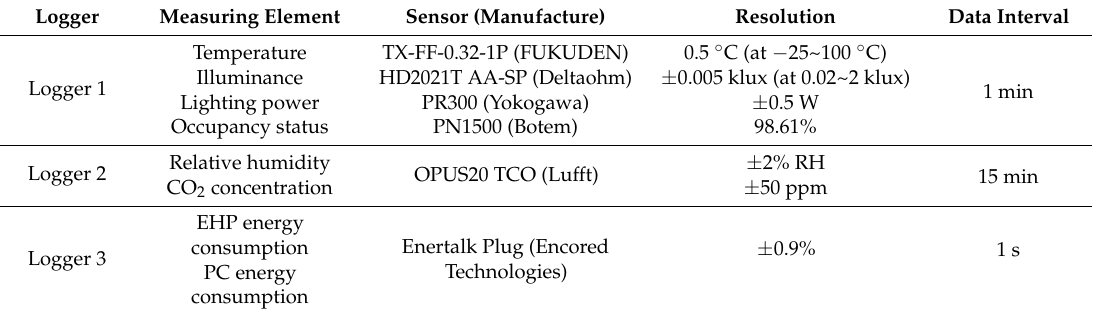
Figure 2. Status of indoor and outdoor environment, energy and occupancy sensor items, and data storage. Table 3. Detailed information on measurement data and